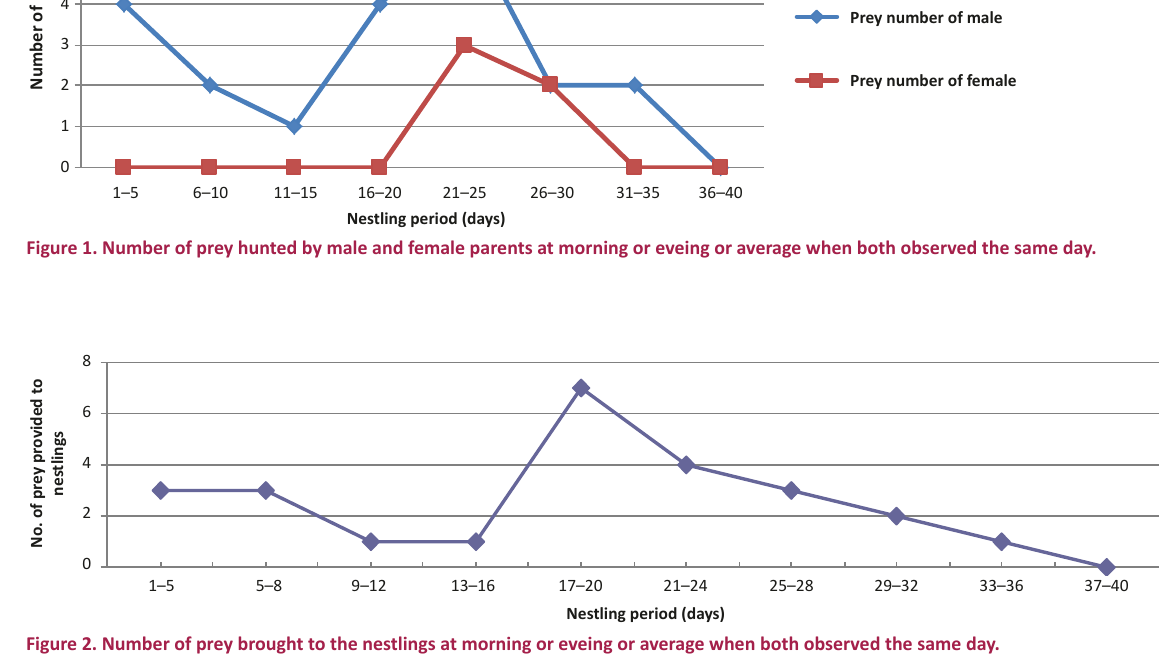
Figure 2. Number of prey brought to the nestlings at morning or evening or average when both observed the same